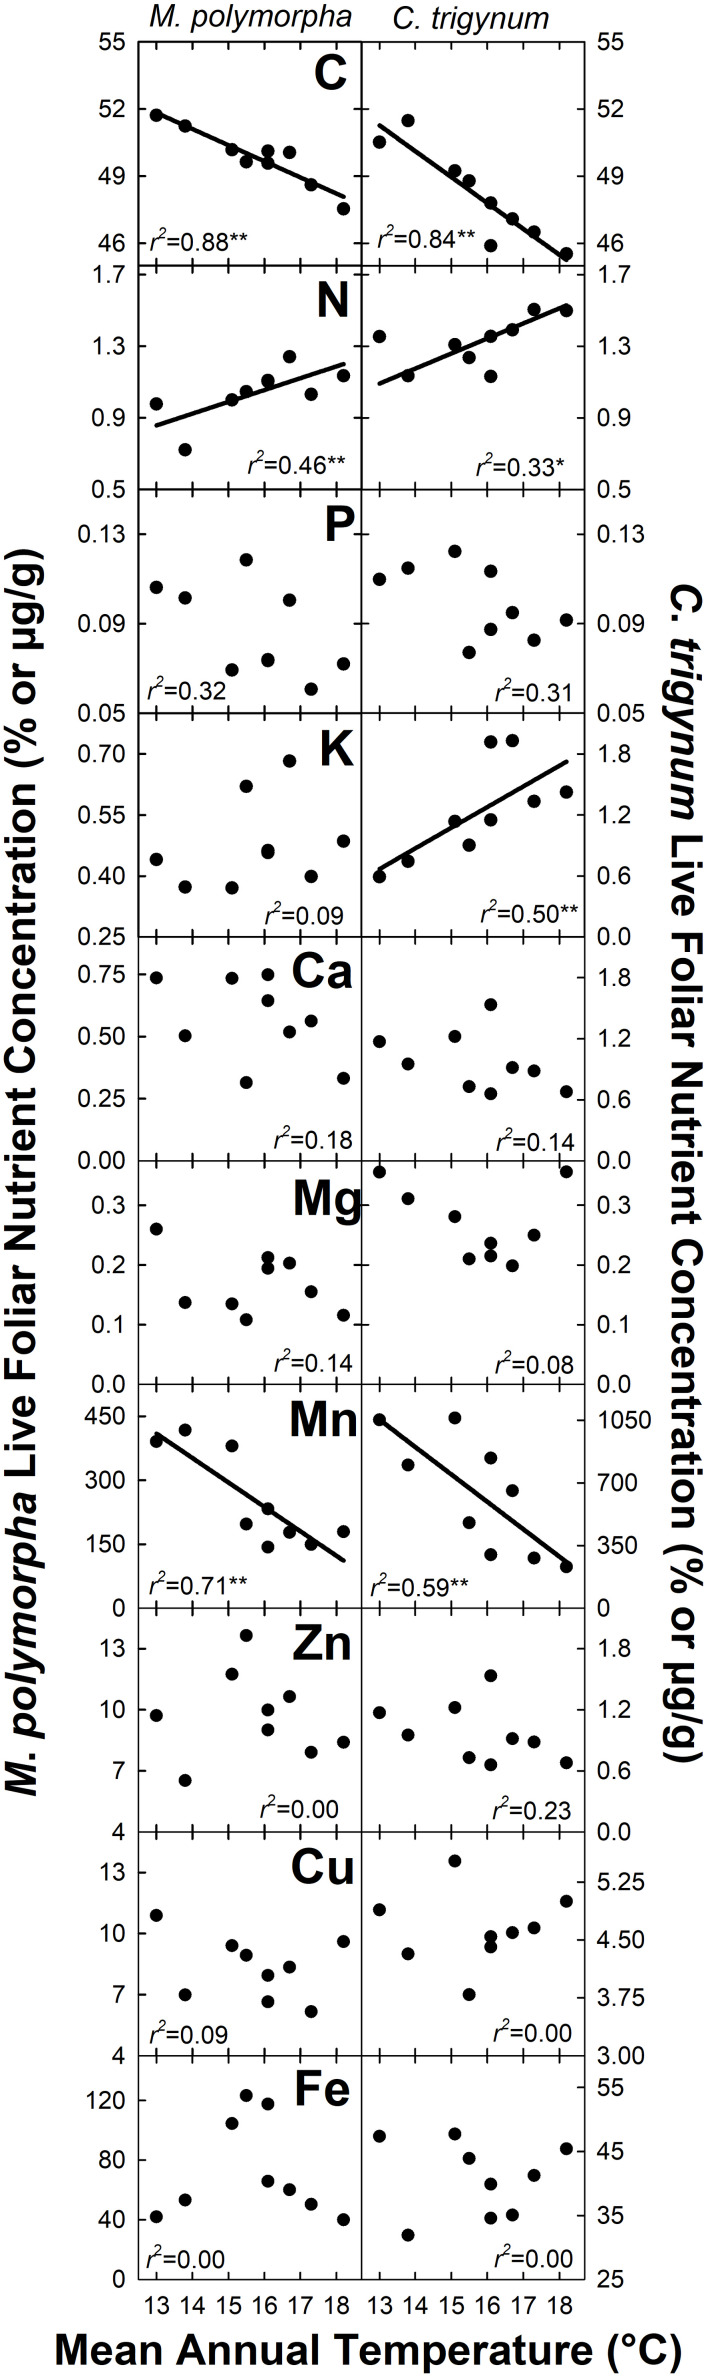
Nutrient concentration of live foliage biomass for the two dominant trees (Metrosideros polymorpha and Cheirodendron trigynum) in a Hawaiian tropical montane wet forest across a 5.2°C mean annual temperature gradient. Values are displayed as % for macronutrients (C, N, P, K, Ca, and Mg) and ug g–1 for micronutrients (Mn, Zn, Cu, and Fe). Significance of regression is indicated as *P < 0.10 and **P < 0.05.